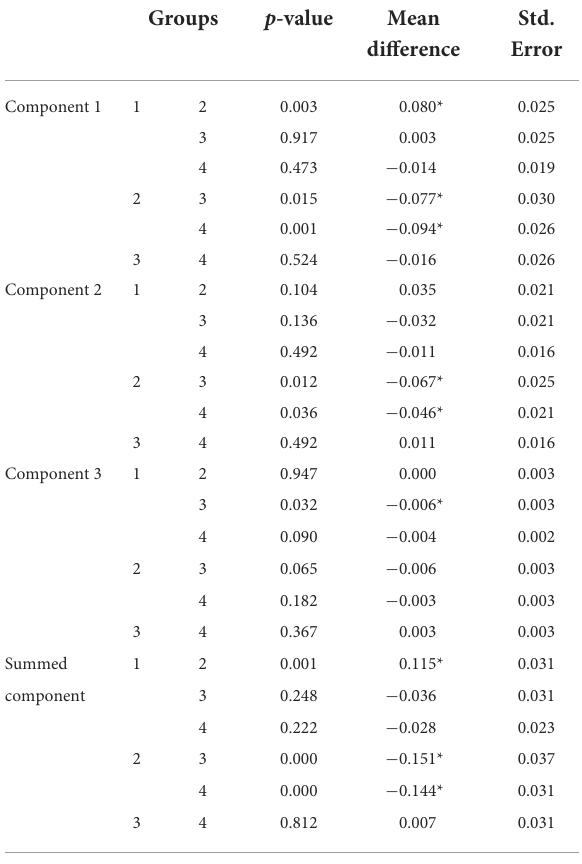
TABLE 2 Results of LSD post-hoc